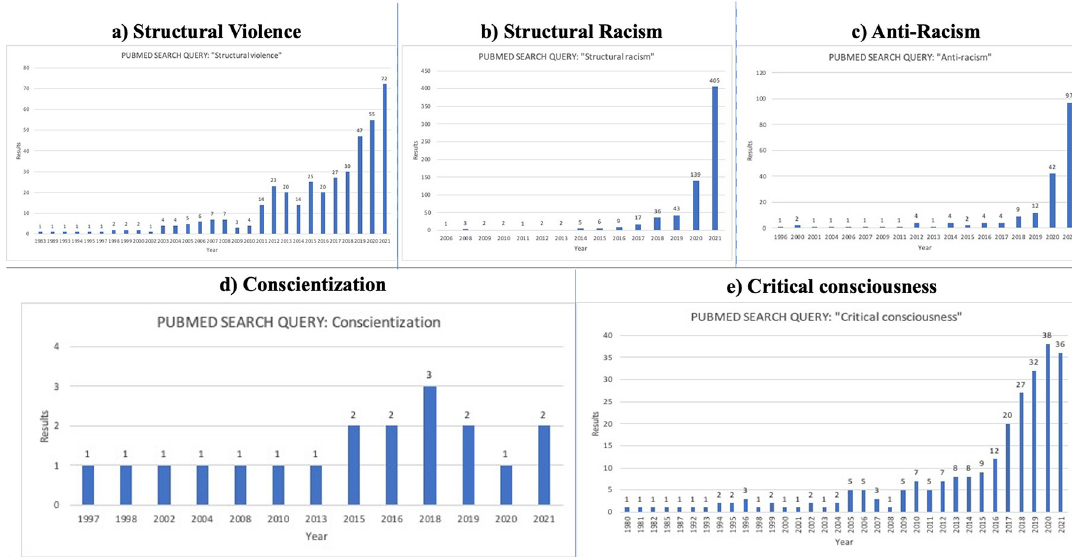
Fig 1. a-e. Results of bibliometric analysis on terms of relevance in the decolonisation movement. See text for methods.